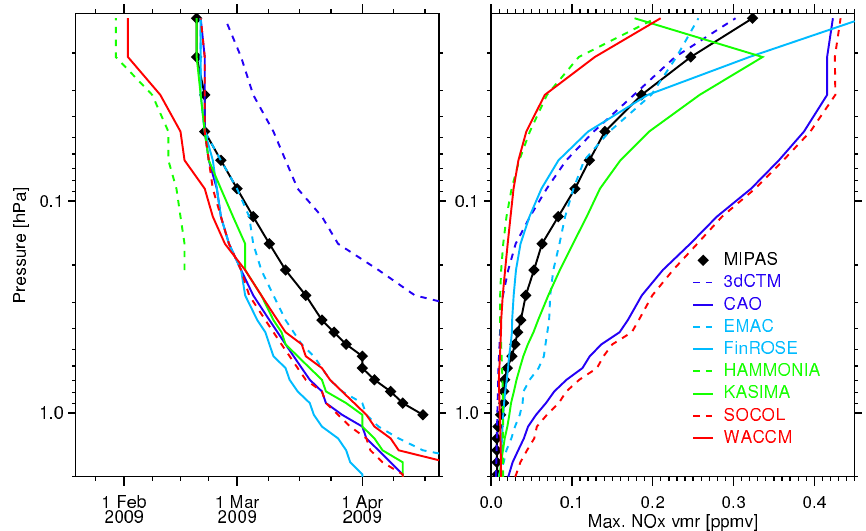
Figure 16. Left: MIPAS-NOM and modelled time evolution of the occurrence of the NO x peak as function of pressure after the ES event. Right: observed and modelled NO x peak values, averaged over 70–90 ◦ N.